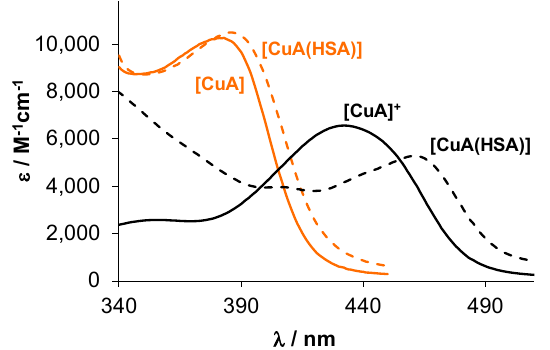
Figure 7. Calculated molar absorbance UV–vis spectra of the binary copper(II)-TSC ([CuA]) and the copper(II)-TSC-HSA ([CuA(HSA)]) ternary complexes in the wavelength range of the CT bands. (Triapine: black lines, STSC: orange lines). {30% ( w / w ) DMSO/H 2 O; pH = 7.4 (20 mM HEPES); T = 25 °C; I = 0.10 M (KCl); ℓ = 5 cm}.